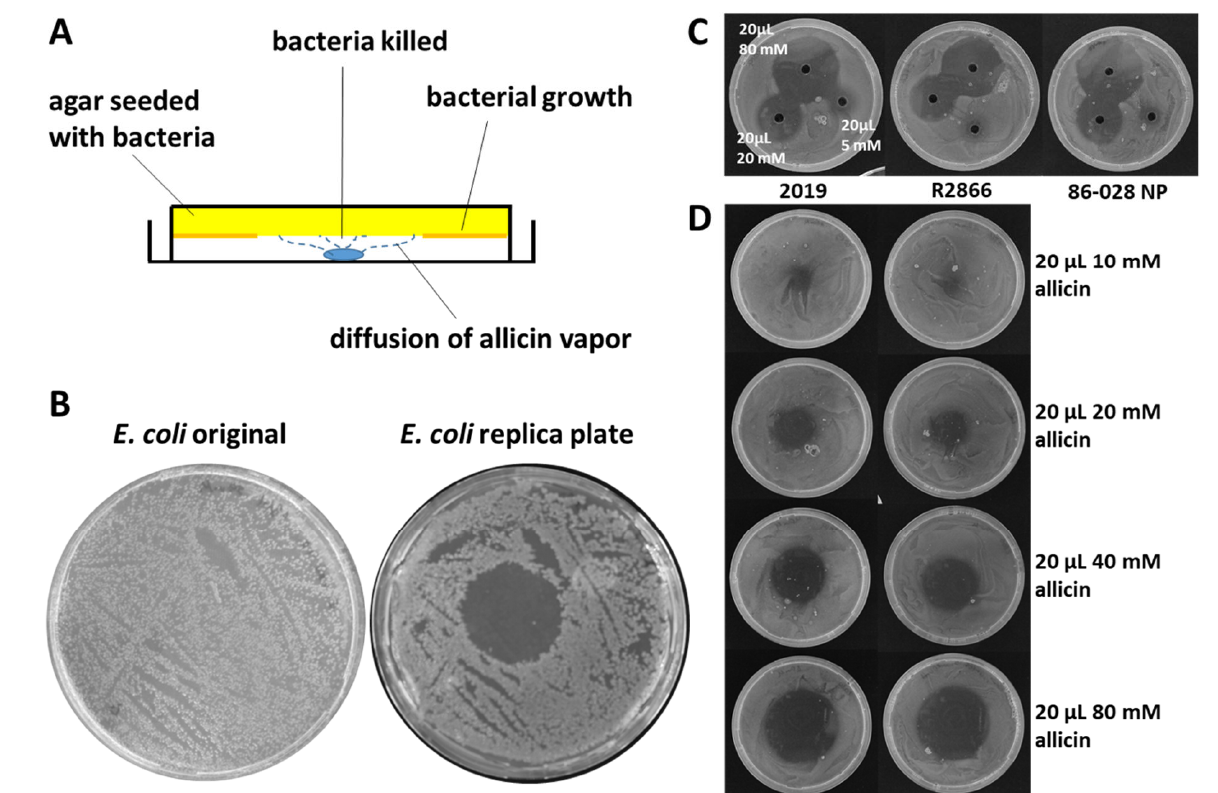
Figure 6. Inhibition of bacteria by allicin vapor and solutions. ( A ) Bacteria ‐ seeded agar in a Petri plate inverted over a drop of allicin solution in the lid prevents the growth of the bacteria and leads to a clear zone after incubation. ( B ) In this variation of the test the inoculum was spread over the surface of agar medium with a Drigalski spatula and allowed to grow overnight at 37 °C to make a lawn on the surface before inverting the plate over a droplet of allicin solution. A replica plate was then prepared from the lawn using a sterile velvet pad and this showed that the growth of bacteria was not only prevented by allicin vapor, but that bacteria in a pre ‐ existing lawn can also be killed outright. ( C ) Agar diffusion test showing the inhibition of the growth of three strains of lung pathogenic Haemophilus influenzae (strains 2019, R2866, and 86 ‐ 028 NP) spread over the surface of agar medium with a Drigalski spatula. Allicin solution (20 μ L) at 5, 20 or 80 mM was pipetted into wells in the bacteria ‐ seeded agar. ( D ) Agar plates of the 2019 and R2866 H. influenzae strains were inverted over a 20 μ L droplet of allicin solution at 10, 20 or 80 mM (absolute amounts = 32.5, 65, 130, and 260 μ g allicin, respectively). Plates were incubated for 17 h at 37 °C.